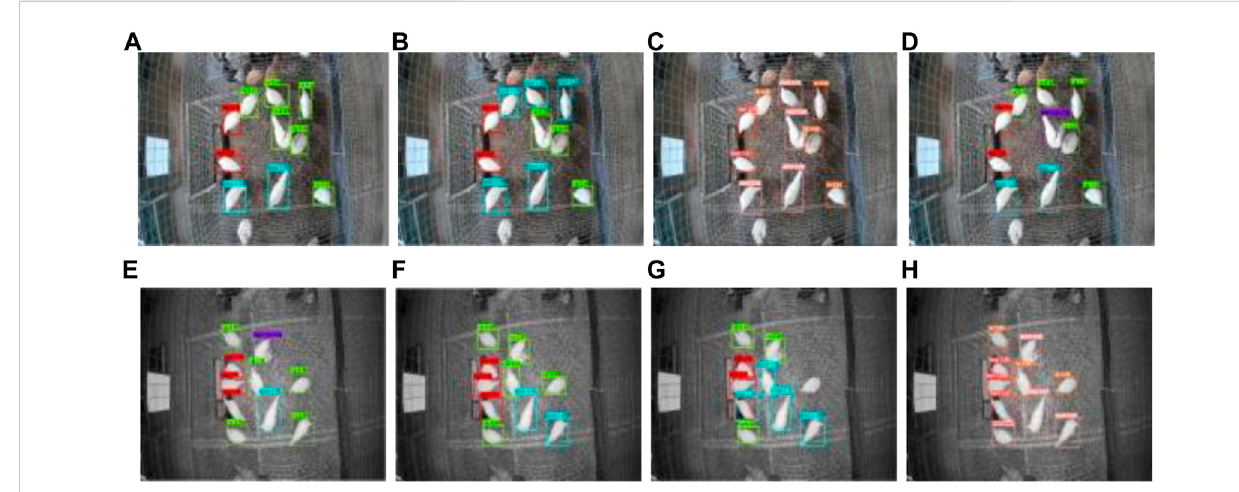
FIGURE 10 Video detection of the FPS values of various algorithms (A) YoloV3 FPS; (B) YoloV4 FPS; (C) Faster-RCNN FPS; (D) YoloV5